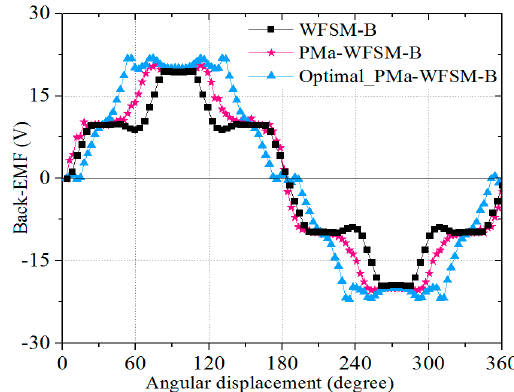
Figure 15. Comparison of Back Electromotive Forces (Back-EMFs) in phase.